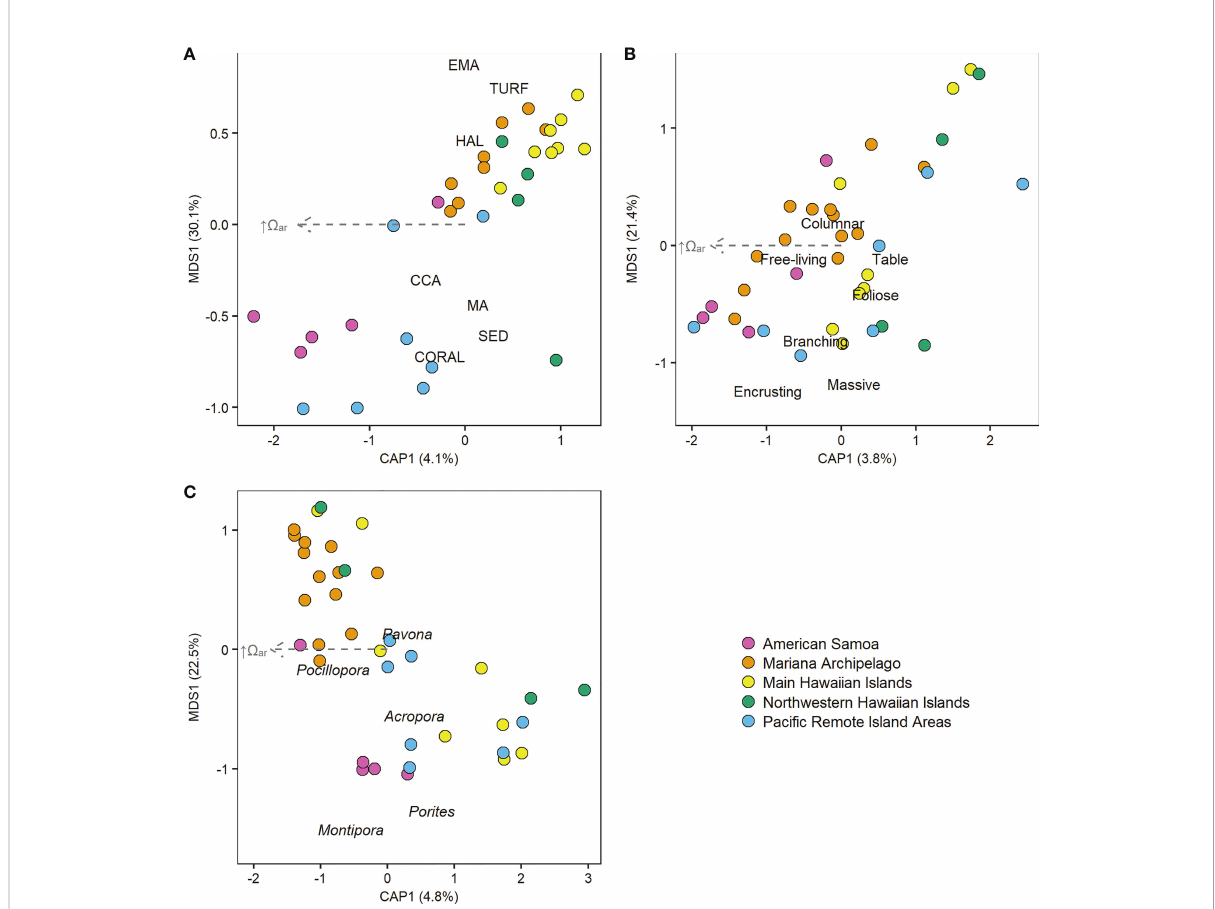
FIGURE 4 Distance-based redundancy analysis (db-RDA) plots of relationship between W ar and (A) benthic percent cover, (B) coral morphology, and (C) composition of the fi ve most common Paci fi c Islands coral genera. Points show 2010 – 2019 mean benthic data for each island colored by region, and gray arrows show the non-signi fi cant linear vectors of increasing W ar . (A) CCA, crustose coralline algae; EMA, encrusting macroalgae; HAL, Halimeda algae; MA, macroalgae; SED,